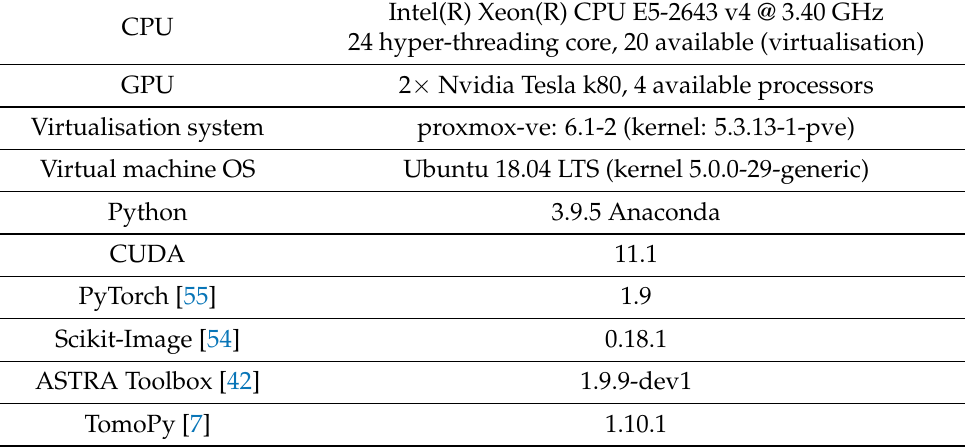
Table 1. System configuration for the algorithm